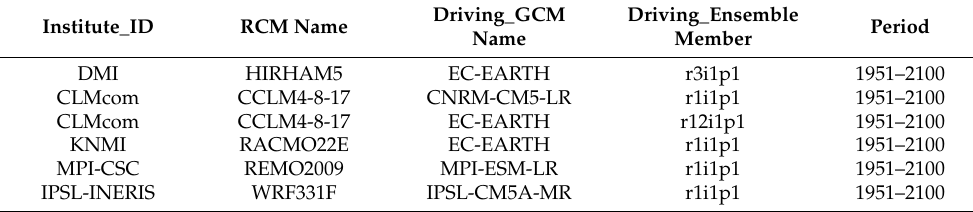
Table 2. Synthetic description of the climate models considered in the multi-model